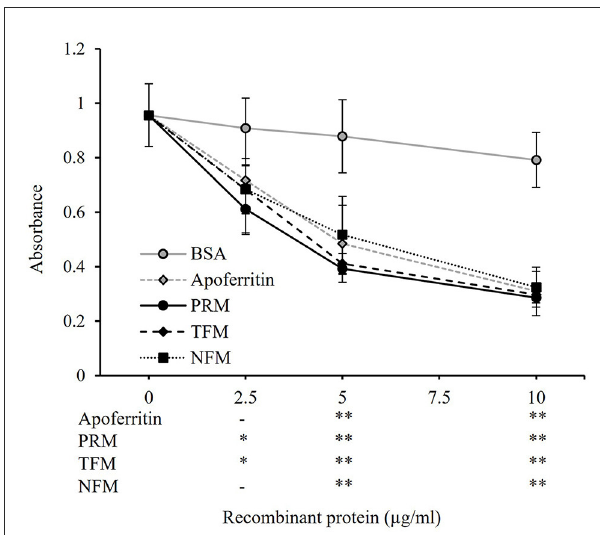
FIGURE3 Iron-binding ability of recombinant ferritin 2 (rFER2) proteins. The iron-binding ability of rFER2 proteins from poultry red mite, tropical fowl mite, and northern fowl mite was assessed by a ferrozine-based colorimetric assay using different concentrations of each rFER2. Ferrozine was used as an indicator agent. Bovine serum albumin and horse apoferritin were used as the negative and positive controls, respectively. The x -axis indicates the amounts of rFER2 proteins used in this assay. Error bars indicate standard deviations. Statistical differences are shown as a comparison to bovine serum albumin (BSA). Asterisks indicate significant differences ( * P < 0.05 and ** P < 0.01).